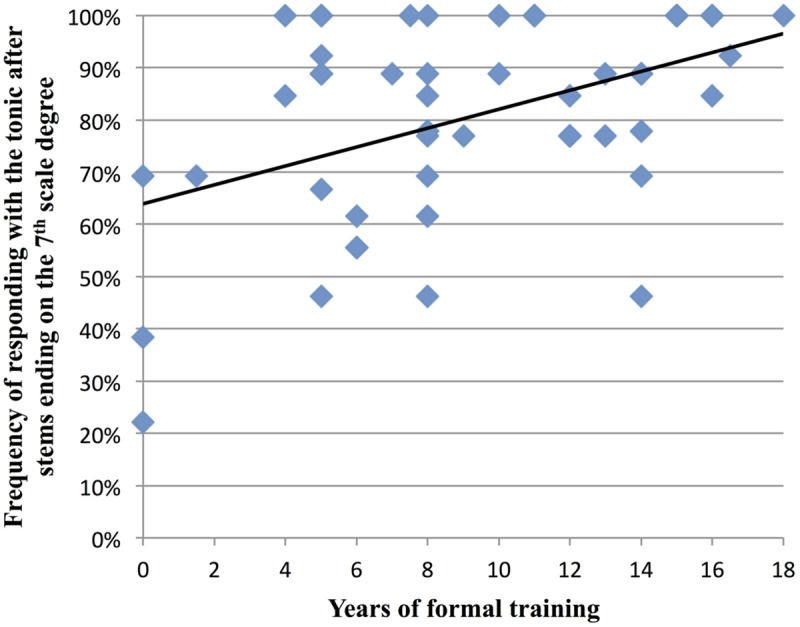
Relationship between participants’ years of formal musical training and how often they sung the tonic after melodic stems that ended on the 7th scale degree. On average, participants sang the tonic 81% of the time after these stems (data for all 50 participants are shown: due to some data points lying directly on top of each other, fewer than 50 data points are visible on the graph).